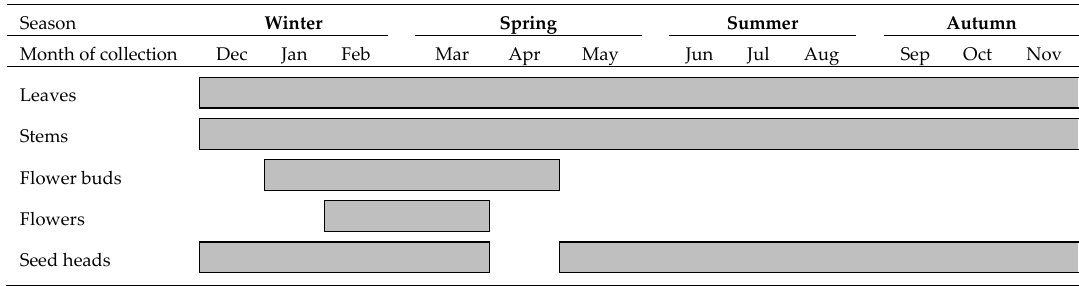
Figure 6. A sampling of several C. ladanifer morphological fractions throughout the year.